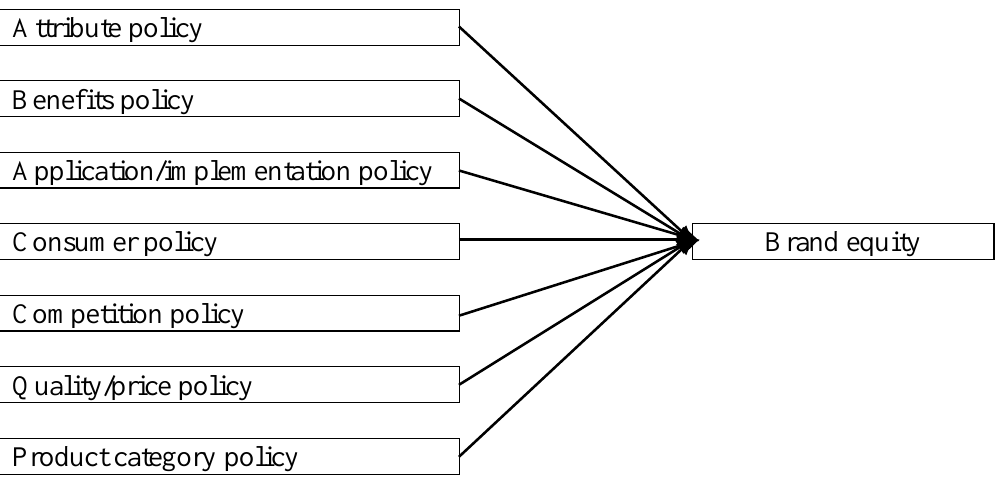
Fig. 1. The structure of the proposed